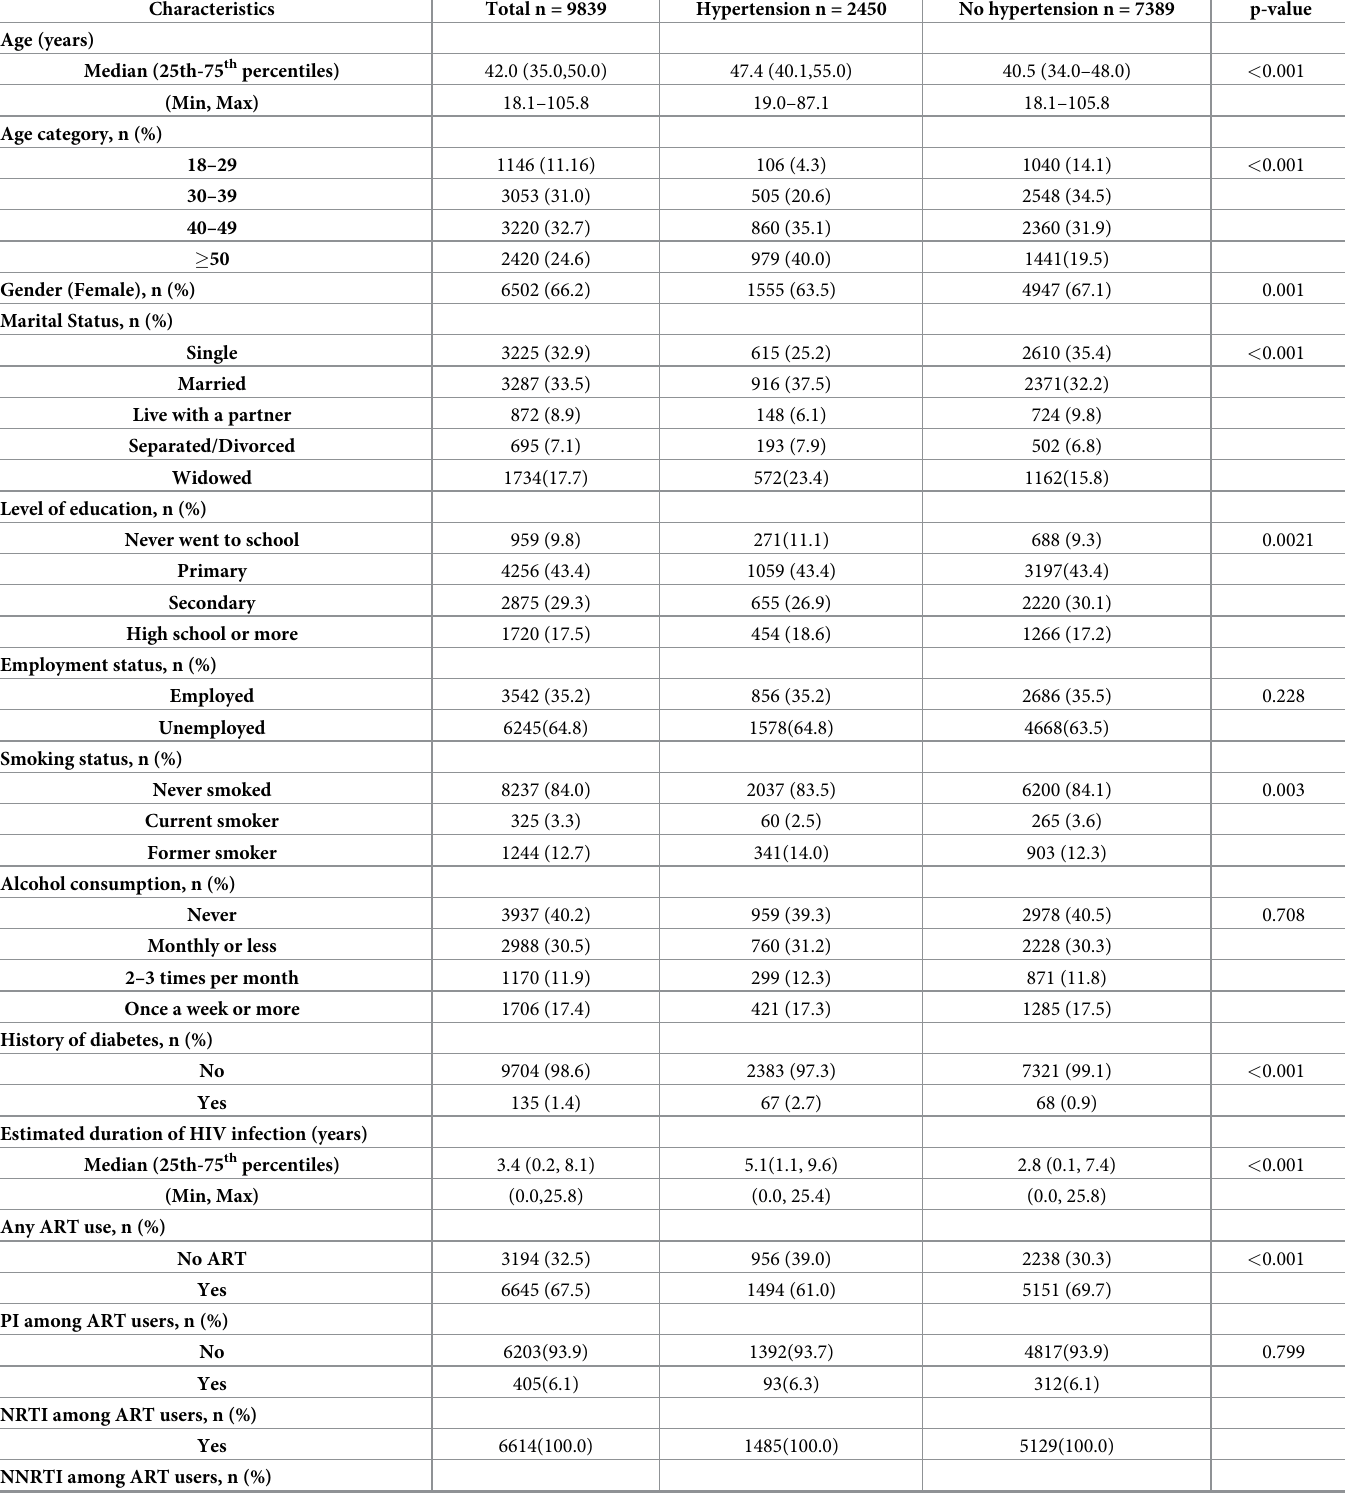
Table 1. Demographic and clinical characteristics of people leaving with HIV/AIDS at enrolment with and without hypertension.